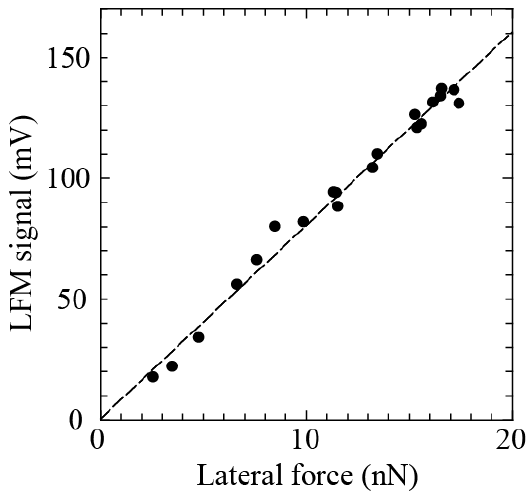
Figure 3. LFM signal vs. lateral